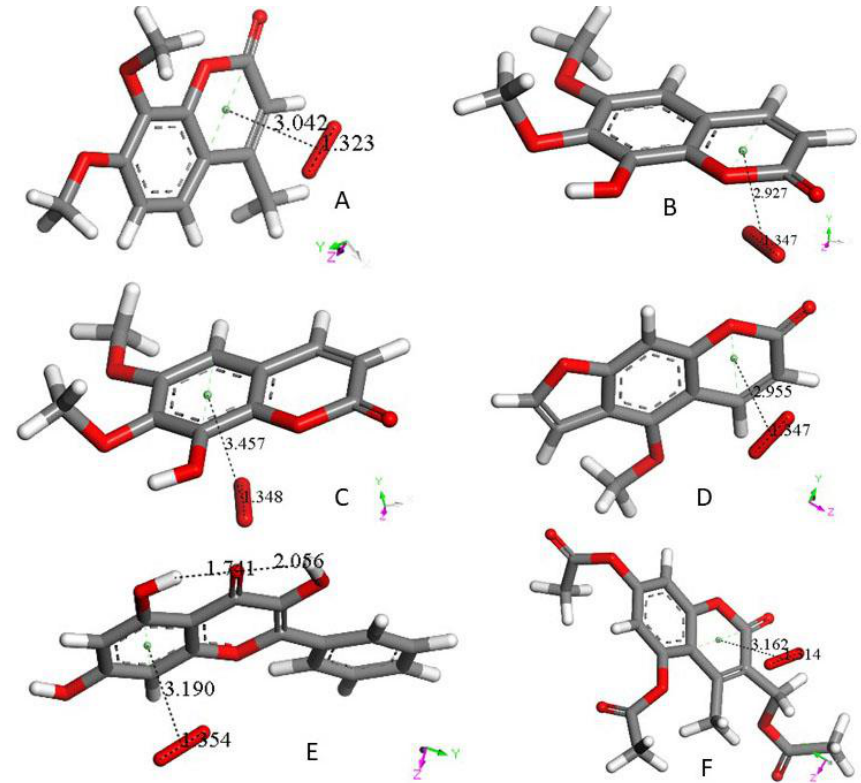
Figure 4. ( A ): 4-Methyl-7,8-dimethoxy-coumarin differs slightly from 4-methyl-7,8-di-hydroxy- coumarin (Figure 1A); the two hydroxyl groups are replaced by methoxy groups. After π - π posing a superoxide radical (O–O bond distance, 1.373 Å) over the pyrone ring (van der Waals separation, 3.50 Å) of this dimethoxy species, geometry optimization shows O–O bond distance of 1.323 Å. This is intermediate between superoxide (1.373 Å) and O 2 (1.26 Å) and indicates a radical-complex formation with both reagents sharing the unpaired electron, having ring and superoxide centroids separated 3.042 Å. ( B ): The DFT interaction between a π - π posed superoxide radical on top of the fraxidin pyrone ring (initial van der Waals separation, 3.50 Å) shows O–O bond distance 1.347 Å, which is intermediate between superoxide (1.373 Å) and O 2 (1.26 Å): this indicates the formation of a radical complex between both reagents, having ring centroid and superoxide centroid 2.927 Å separated, which is somewhat shorter than 3.042 Å for 4-methyl-7,8-dimethoxy-coumarin, shown in ( A ). ( C ): Fraxidin non-pyrone ring was also analyzed for π - π interaction with superoxide. It shows a very weak interaction with superoxide, with centroid separation 3.457 Å, very similar to the van der Waals separation, 3.50 Å. ( D ): Bergamottin, a furanocoumarin shows the π - π interaction between its pyrone ring and superoxide with short separation between centroids of 2.955 Å, similar to the coumarin shown in ( B ), 2.927 Å. ( E ): DFT π - π interaction between galangin non pyrone ring and superoxide [25] (that are initially van der Waals separated, 3.50 Å [also shown in Scheme 2a]) indicates a minimum of energy with stronger interaction, (3.190 Å separation between centroids) than in the related non pyrone ring of fraxidin, 3.457 Å ( C ). ( F ): 4-Methyl,3,6,8-triacetate-coumarin has been described as a less active scavenger of radicals than those containing hydroxyl substituents. After DFT minimization, it shows separation between centroids, 3.162 Å, slightly longer than in bergamottin, 2.955 Å ( D